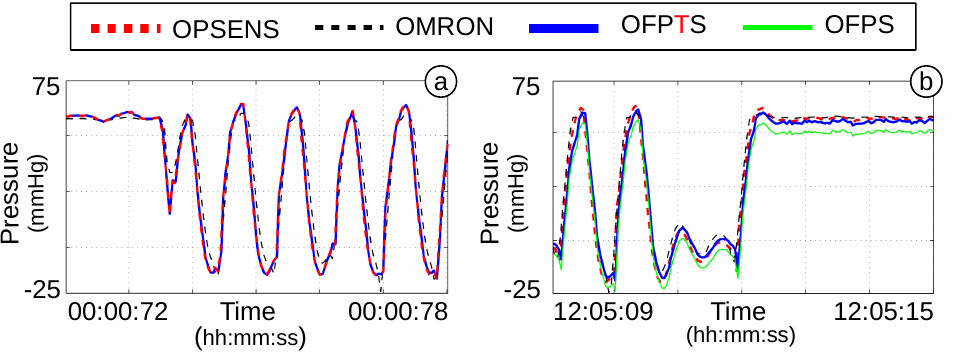
Figure 20. ( a ) Pressure in the first minute; ( b ) pressure after 12 h of continuous